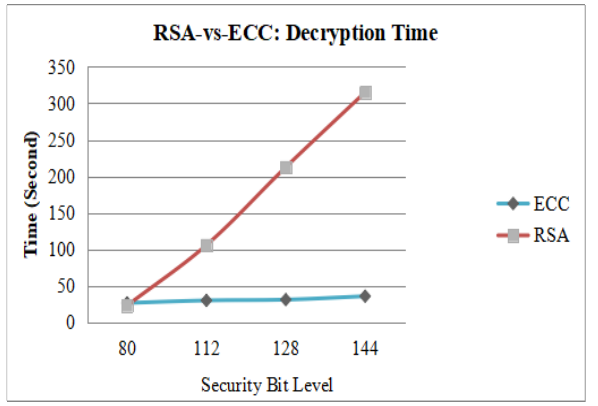
Figure 9. Decryption time (in sec.) of RSA and ECC